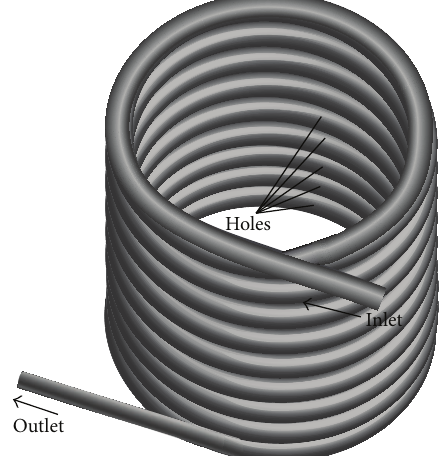
Figure 8: The helical coil tube with